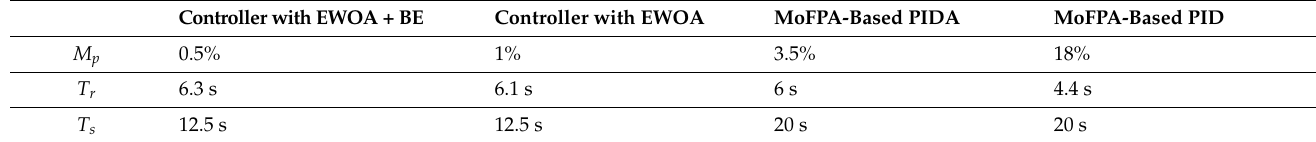
Table 1. Performance specification due to first case.